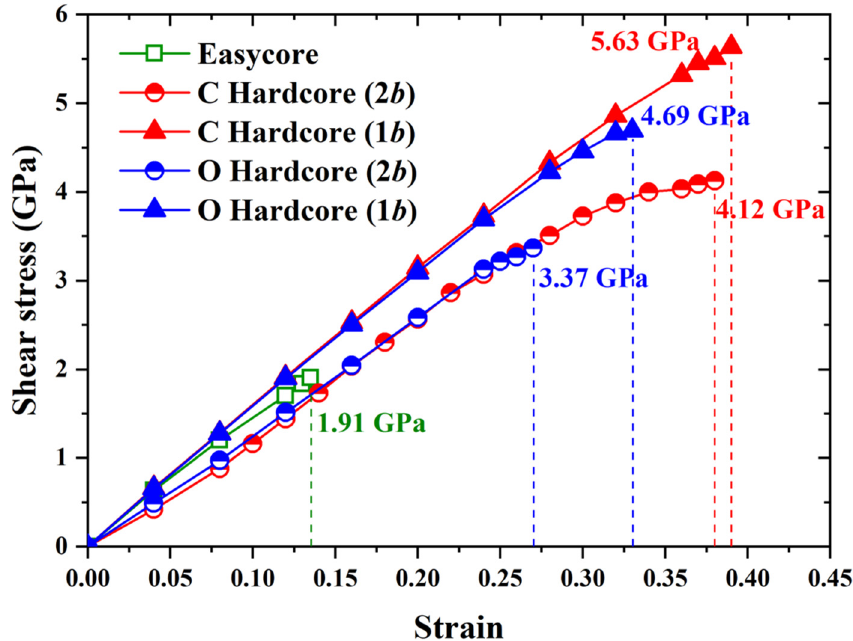
Figure 6. Shear stress variation as a function of strain for pure and decorated screw dislocation in Mo. 1 b and 2 b represent the distance between the solute (C or O) atoms along <111> direction. Microscopically, the motion of screw dislocations in bcc metals at a finite temperature